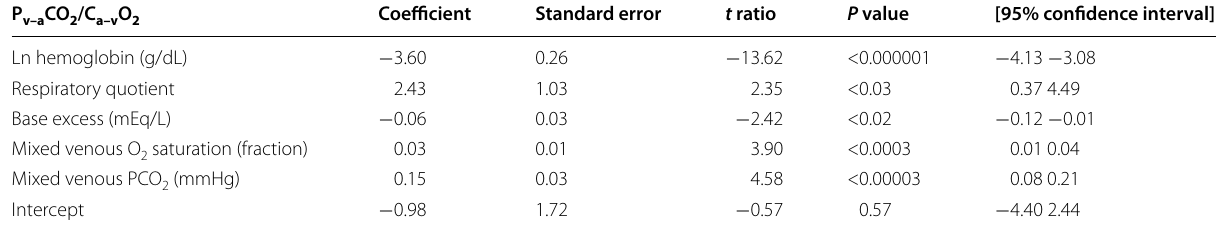
Mixed venous PCO 2 (mmHg)